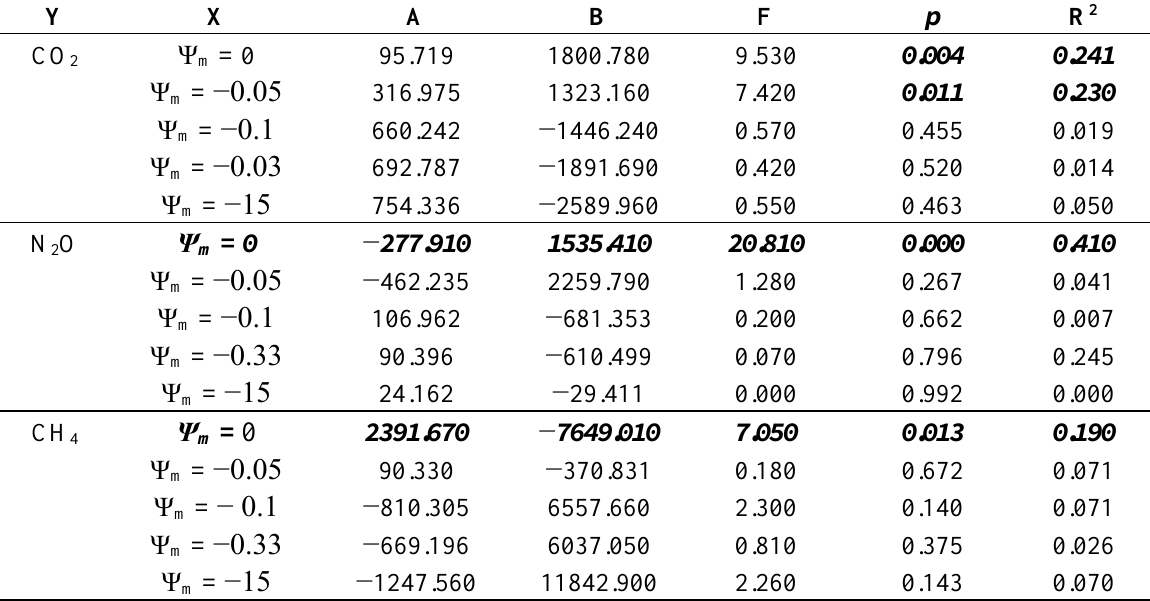
Table 3. Linear regression analysis ( Y = a + b x ) between soil moisture held at five different levels of matric potential and greenhouse gases